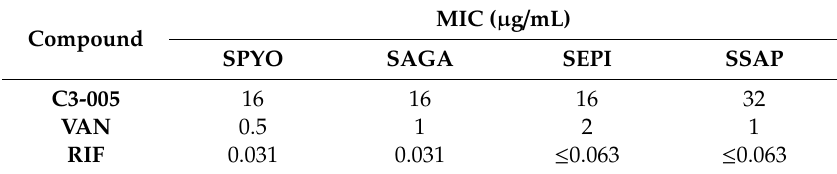
Table 3. Antimicrobial activity (MIC μ g/mL) of C3-005 against representative Gram-positive bacterial pathogens.